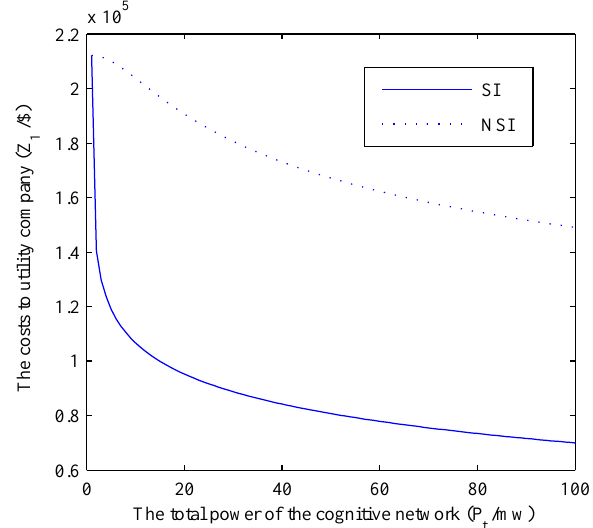
Figure 7. The costs to utility company under Sensing Information (SI) and Non-Sensing Information